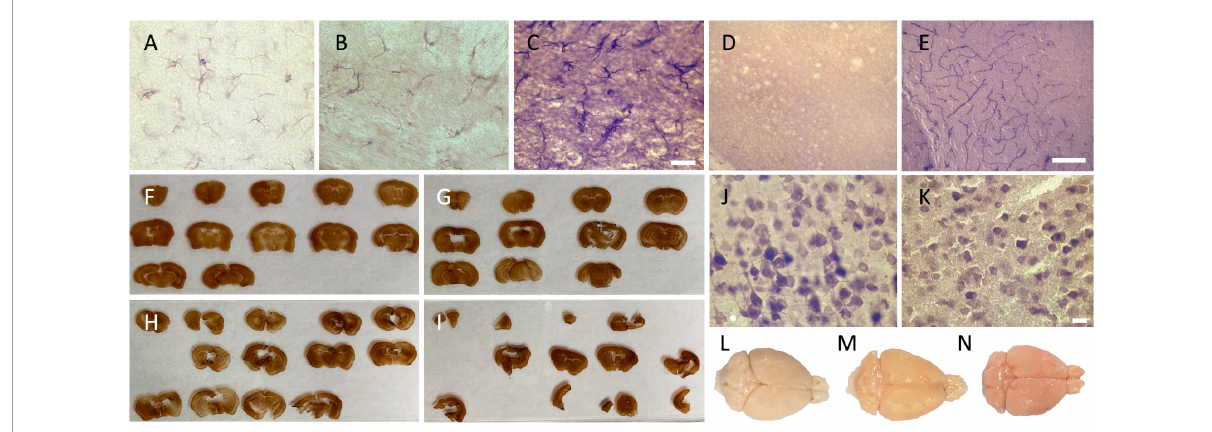
FIGURE1 Photomicrographs of the different categorical variables that were assessed. Photomicrographs (60X) of the background intensity (A) light = 2; (B) intermediate = 1; and (C) dark = 0, acquired in the external capsule of GFAP-labeled slices, where we can see the presence of labeled astrocytes. Scale bar = 20 µ m [valid for (A–C) ]. (D) Photomicrographs of the presence of dilated vessels (20X) (perfusion quality) and (E) of endogenous peroxidase presence in the blood vessels (red cells and endothelial cells) (20X) (histology quality) in the cortex, also acquired in GFAP-labeled slices (no astrocyte on the picture since they were only present in the white matter). Scale bar = 100 µ m [valid for (D,E) ]. Ease of manipulation (F) very good = 3; (G) good = 2; (H) poor = 1; and (I) very poor = 0. Photomicrographs (60X) of (J) a uniform neuropil and regular cell contours in the secondary motor cortex, and (K) a fissured and irregular neuropil and cell contours, also acquired in the secondary motor cortex of the closest slice to figure 33 in the Mouse Brain Atlas. Scale bar = 10 µ m [valid for (J,K) ]. Brain color (perfusion quality) (L) beige = 2; (M) heterogenous = 1; and (N) pink =